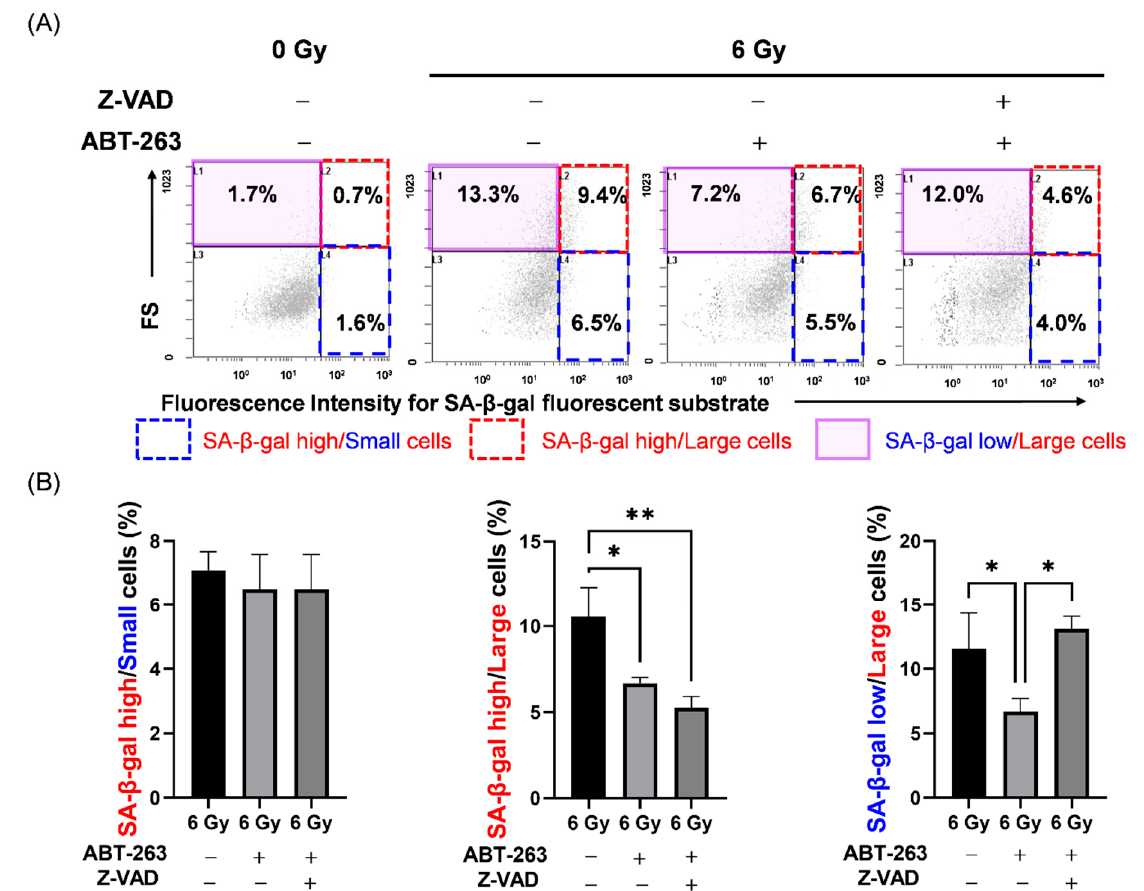
Figure 7. Effect of the caspase inhibitor Z-VAD on changes in cell populations of irradiated A549 cells by ABT-263. ( A , B ) A549 cells irradiated at 6 Gy were cultured for 24 h prior to the addition of ABT-263 (5 μ M) to the culture. Z-VAD was added to the culture 1 h before ABT-263 administration. After 48 h of culture, SA- β -gal activity and FS, which indicates cell size, were analyzed by flow cytometry. ( A ) Representative cytograms of FS signals and fluorescence intensities of SA- β -gal are shown. The inset numbers of the cytograms indicate the percentage of SA- β -gal high/FS low (SA- β -gal high/small) cells (blue region), SA- β -gal high/FS high (SA- β -gal high/large) cells (red region), and SA- β -gal low/FS high (SA- β -gal low/large) cells (purple region). ( B ) The percentages of each population are shown. Data are presented as the mean ± SD of independent experiments. * p < 0.05, ** p < 0.01.